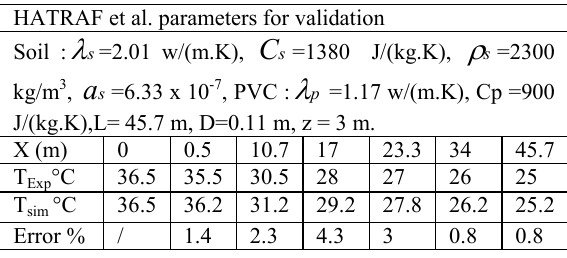
Table 5. The outlet air temperature of EAHE Validation. HATRAF et al. parameters for validation